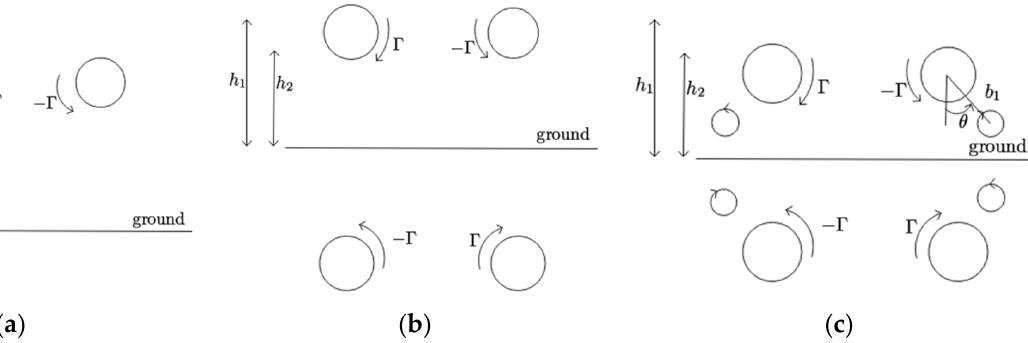
Figure 3. Vortex system in different phases approaching the ground: ( a ) out-of-ground effect (OGE) phase; ( b ) near-ground effect (NGE) phase; ( c ) in-ground effect (IGE) phase.